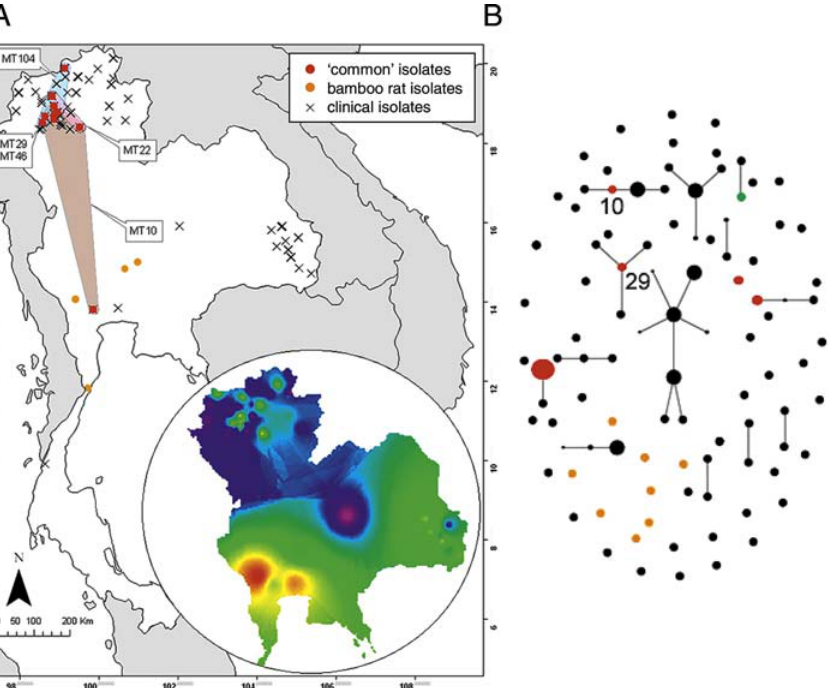
Figure 2. Spatial Distribution of Isolates and Genetic Diversity in Thailand (A) Spatial distribution of sampled isolates in Thailand. Isolates that are found to co-infect both humans and bamboo rats are shown in red, and the clone range of each of these co-infecting MTs is shown as coloured regions. Inset shows the geographic variation of the PC1, which accounts for 18.8% of the total genetic variation. Spatial interpolation of the PC1 values (with colours representing the predicted degree of difference between sample points) illustrates gradients in allele frequencies between northern, eastern, and south-central Thailand. (B) eBURST analysis of the Thailand P. marneffei dataset, with isolates coloured as noted in (A). The single green point refers to an isolate that was recovered from soil. Each clone is represented by a point, the area of which is representative of the frequency of the clone. Clones that differ from one another at a single locus, and are thus inferred to be directly related (single locus variants), are joined by lines. DOI: